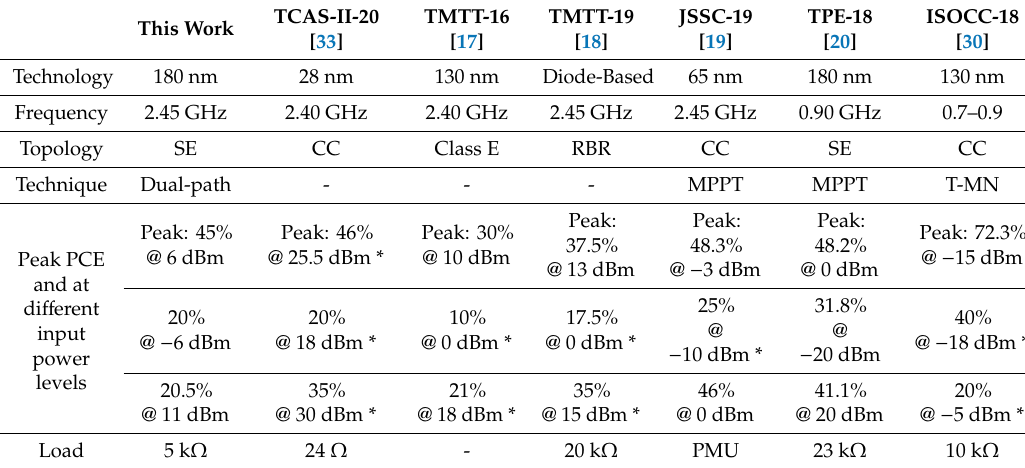
Table 1. Performance summary.